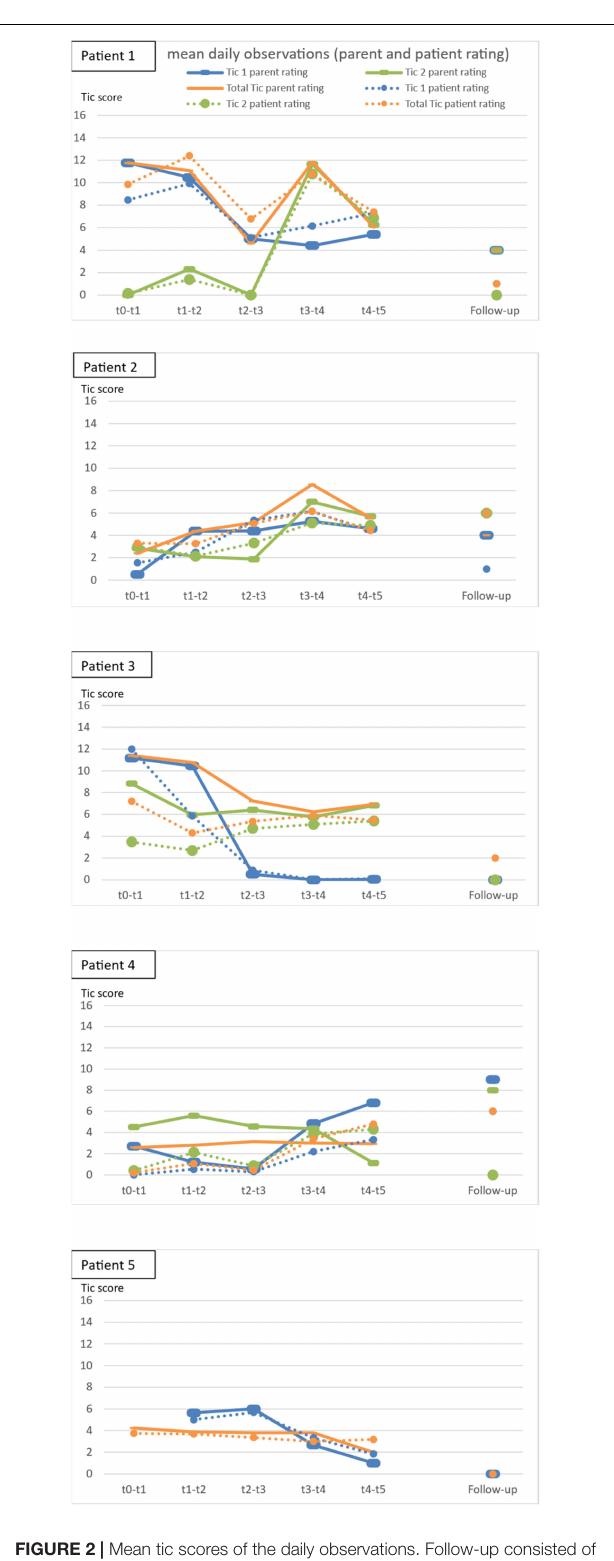
FIGURE 2 | Mean tic scores of the daily observations. Follow-up consisted of only one observation. At the beginning, patient 5 observed different tics, which were no longer present; she therefore started observing the headshaking at t1, which was treated later